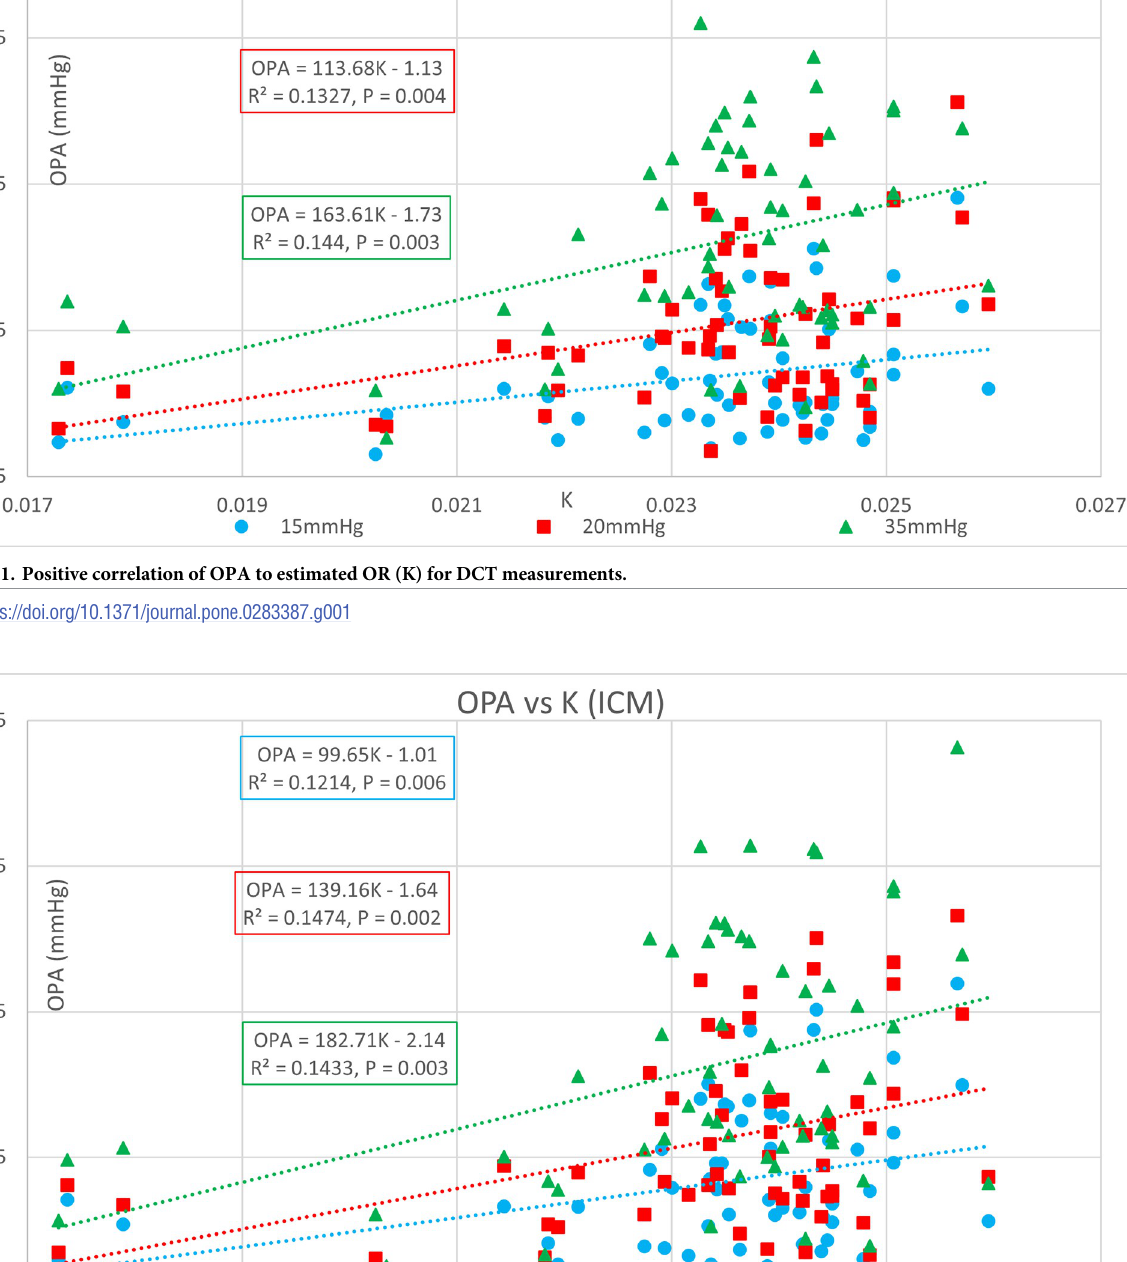
PLOS ONE | https://doi.org/10.1371/journal.pone.0283387 March 23,